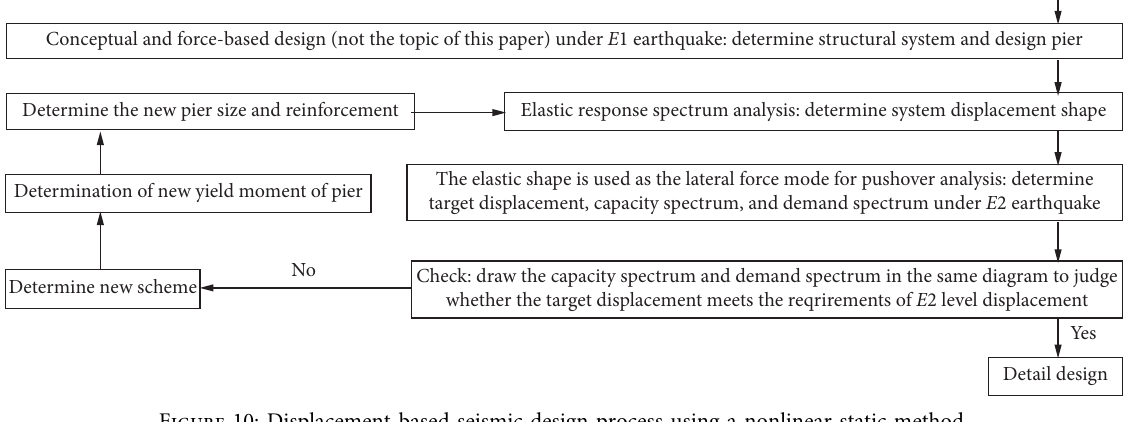
Figure 10: Displacement-based seismic design process using a nonlinear static method.